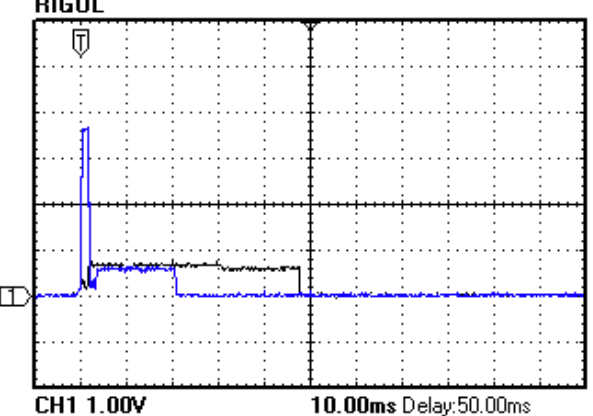
Figure 5 . Current consumption of CRC - 32 generator of fixed frequency ( black ) and switched frequency ( blue ) for data size 500 .